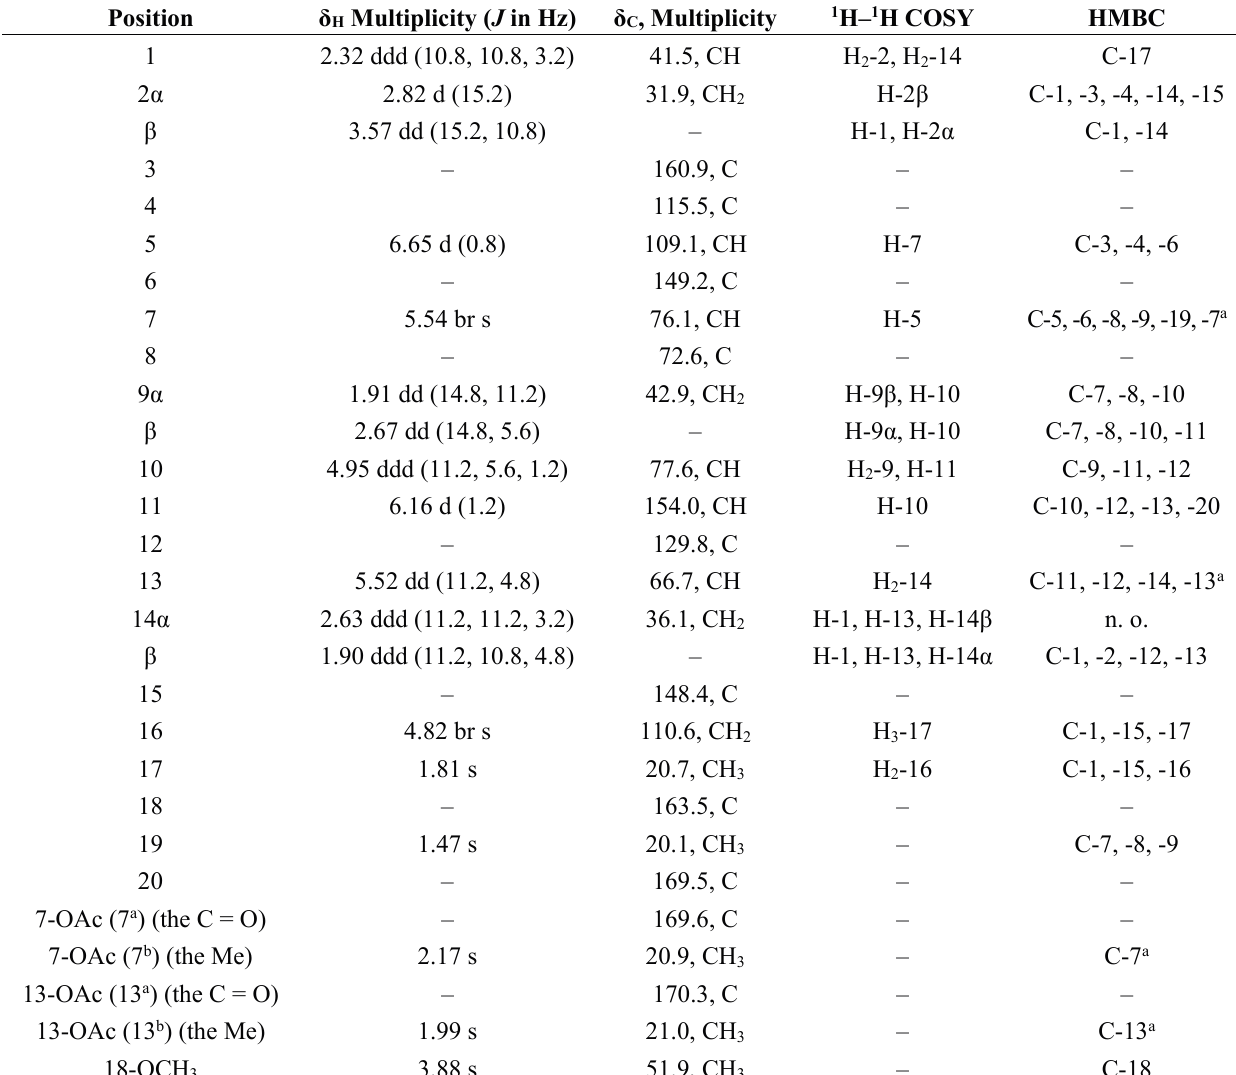
Table 2. 1 H (400 MHz, CDCl 3 ) and 13 C (100 MHz, CDCl 3 ) NMR data, 1 H– 1 H COSY and HMBC correlations for cembrane 4